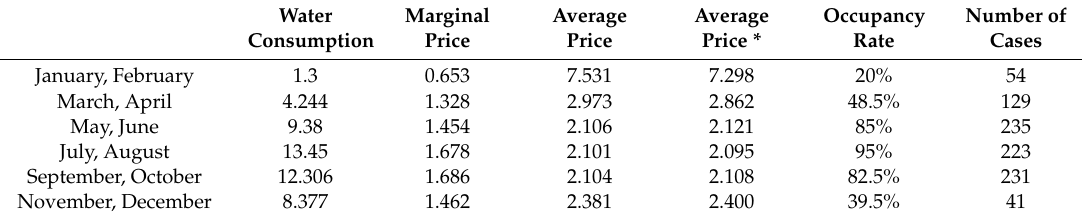
Table 5. Median of key variables for di ff erent two-month periods.